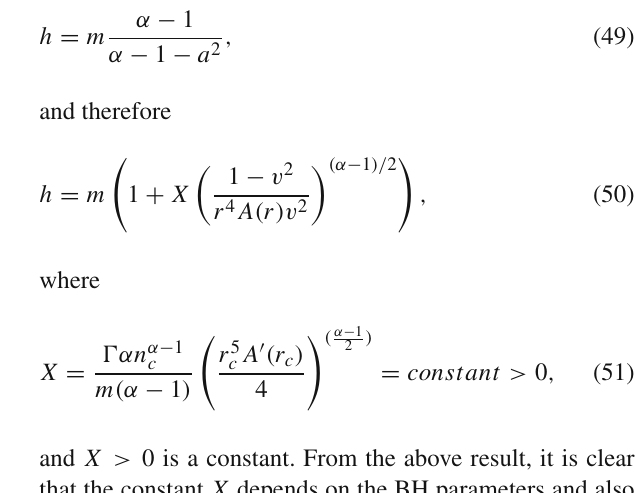
parameters are r c ≈ 1 . 32827, v c = 0 . 70716, H c ≈ 1 . 27174. Bot- tom panel (Schwarzschild BH) displays the behavior of Eq. (39) with Schwarzschild BH parameters γ = 0, k = 0, β = 1. The values of the critical parameters are r c = 2 . 5, v c = 0 . 70716, H c ≈ 0 . 143108. The representation of colors in H = H c → orange, H > H c → magenta and yellow, H < H c → purple and